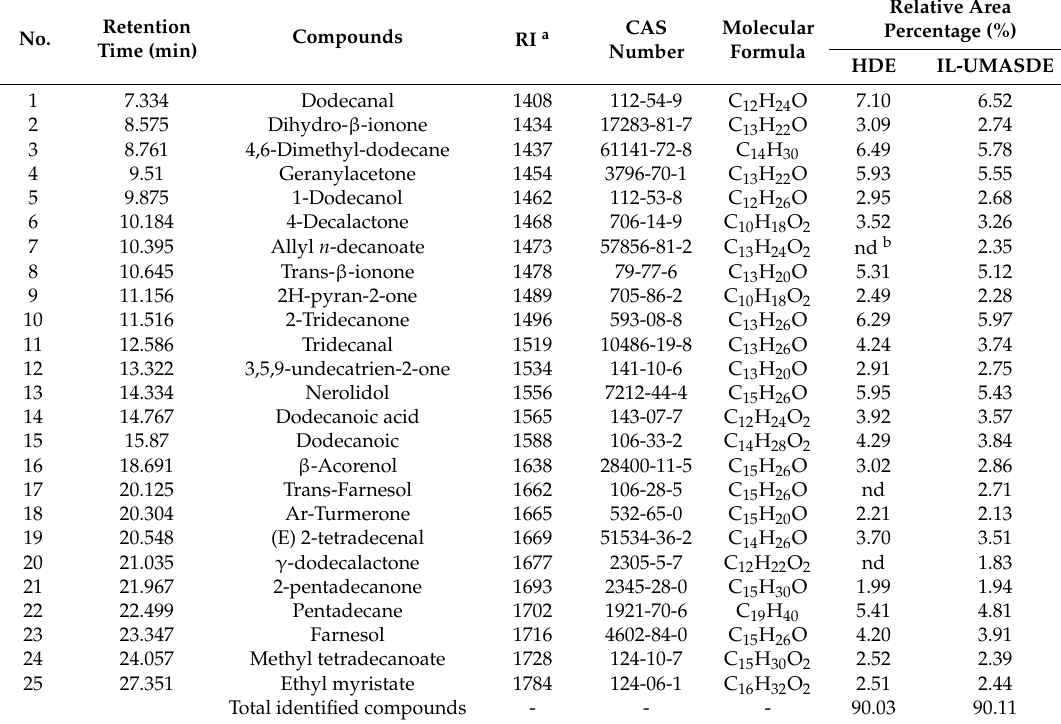
Table 3. Chemical composition of essential oils by GC-MS